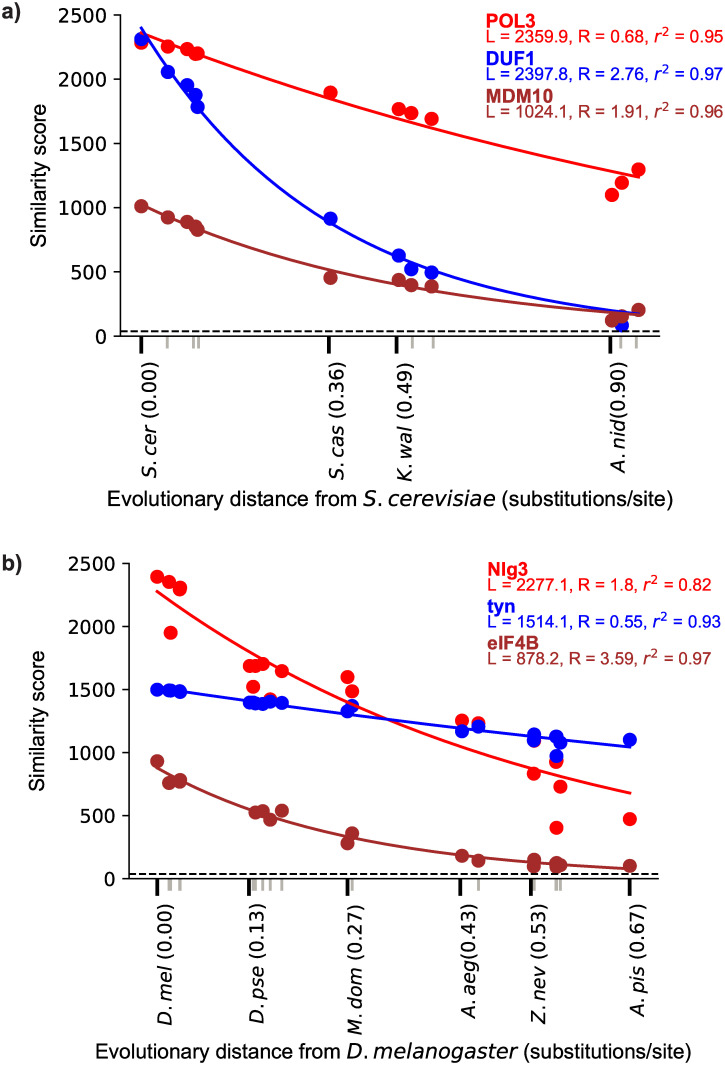
Depictions of the fit of the null model of similarity score, as defined in the text, decline with evolutionary distance for 3 representative proteins from Saccharomyces cerevisiae (a) and Drosophila melanogaster (b).Colored points represent the BLASTP score between the protein and its ortholog in the species that is at the evolutionary distance indicated on the x-axis. Tick marks on the x-axis represent each of the species used here. For visual clarity, only some species names and evolutionary distances are included, indicated with black tick marks; gray tick marks represent the other unlabeled species. The dashed line represents the detectability threshold, the score below which an ortholog would be undetected at our chosen E-value of 0.001. The best-fit values of a and b are shown for each protein. The r2 value is also shown and was calculated from a linear regression of the log of the similarity score versus evolutionary distance. All data in these figures are available at https://github.com/caraweisman/abSENSE, under Fungi_Data (panel a) and Insect_Data (panel b).